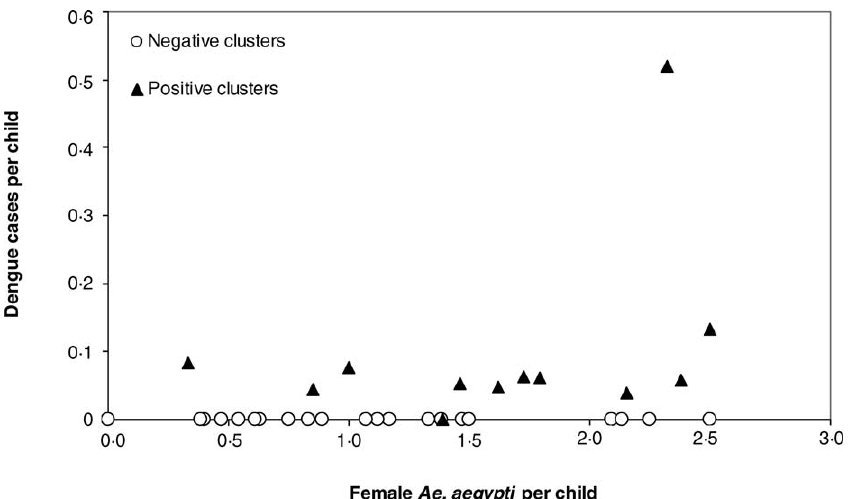
Figure 4. Relationship between Vector Density and Dengue Cases Relationship between the number of Ae. aegypti females per child and dengue transmission within 12 positive and 22 negative cluster investigations in 2004 and 2005. Dengue transmission is expressed as the number of positive PCRs on days 0 or 15 of study or of dengue seroconversions between days 0 and 15 per child per cluster.